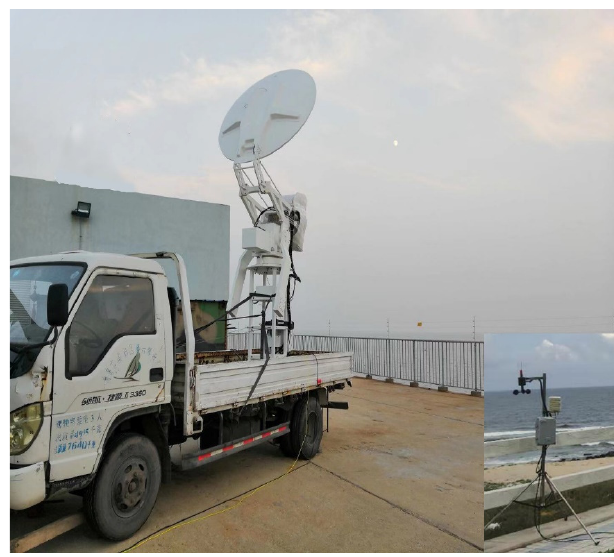
Figure 1. The location of the radiometer used in this study. Point A is located near Qingdao, Shandong province, China. The ground-based microwave radiometer was set up at point A for observation, facing the open ocean in the southwest direction. There are no islands within 300 km ahead in the observation direction of the radiometer. The images in this figure were provided by google earth.